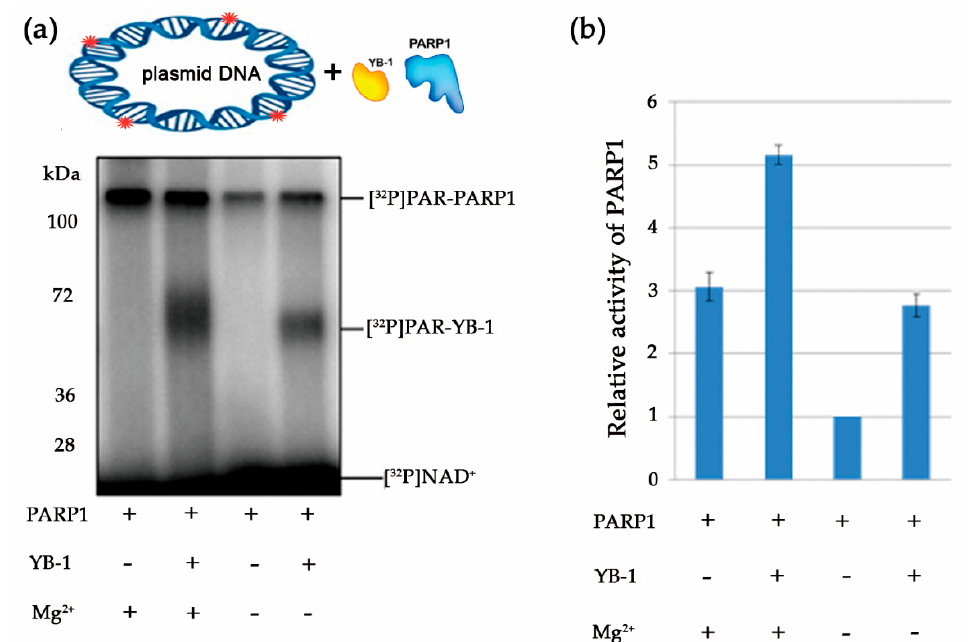
Figure 7. YB-1 stimulates PARP1 activity in the presence of damaged plasmid DNA. ( a ) Protein PARylation in the presence of damaged plasmid DNA and [ 32 P]NAD according to SDS-PAGE and phosphor imaging. The reaction mixtures contained 30 nM PARP1, 4 µ M NAD + and [ 32 P]NAD (0.4 µ Ci) 560 nM YB-1, 3 nM plasmid DNA, and 10 mM EDTA or 5 mM MgCl 2 , as indicated. ( b ) Quantification of PARP1 activity. PARP1 (30 nM) was incubated with 3 nM plasmid DNA, 4 µ M NAD + and [ 32 P]NAD (0.4 µ Ci) in the presence of 560 nM YB-1, and either 10 mM EDTA or 5 mM MgCl 2 , as indicated. 32 P-PAR–modified proteins were TCA-precipitated and counted. The relative level of PAR synthesis was normalized to the level of PAR synthesis catalyzed by PARP1 alone for 60 min without co-factors. The experiments were performed at least three times; the histogram shows the means ± SD of three independent